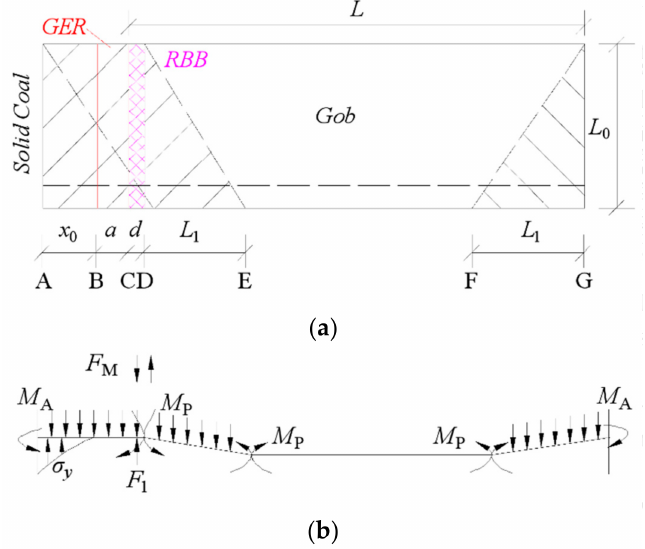
Figure 4. Roof-cutting mechanical model of GER: ( a ) Plan view: supported by three edges (periodic weighting) and ( b ) Section view: loading state of caved